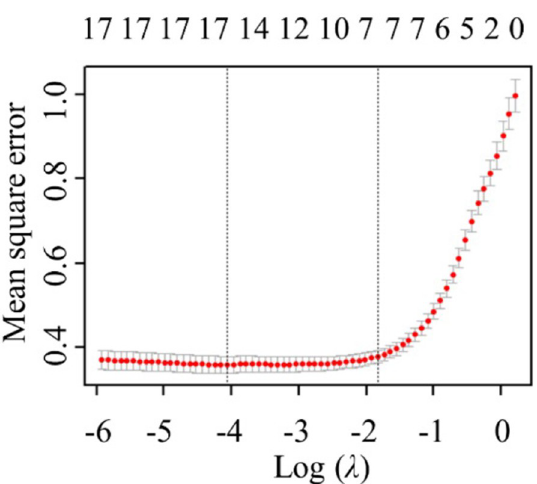
Fig 6. The corresponding trend of λ and the number of